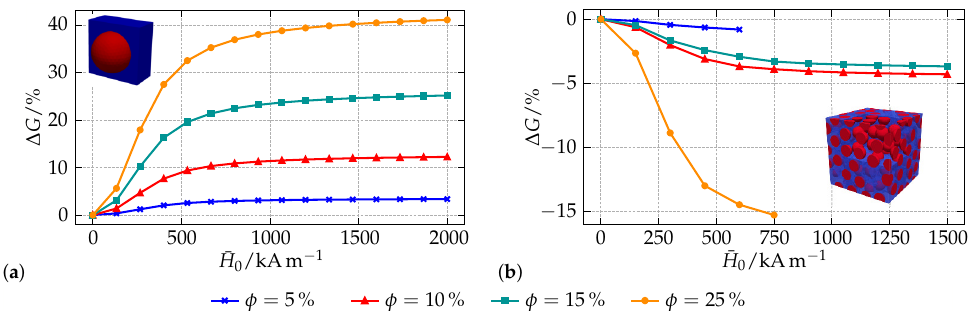
Figure 4. Simulation results for the MR effect in MAEs with different microstructures: ( a ) lattice-like cubic microstructure, and ( b ) random microstructure with varying particle-volume fractions. Data taken from